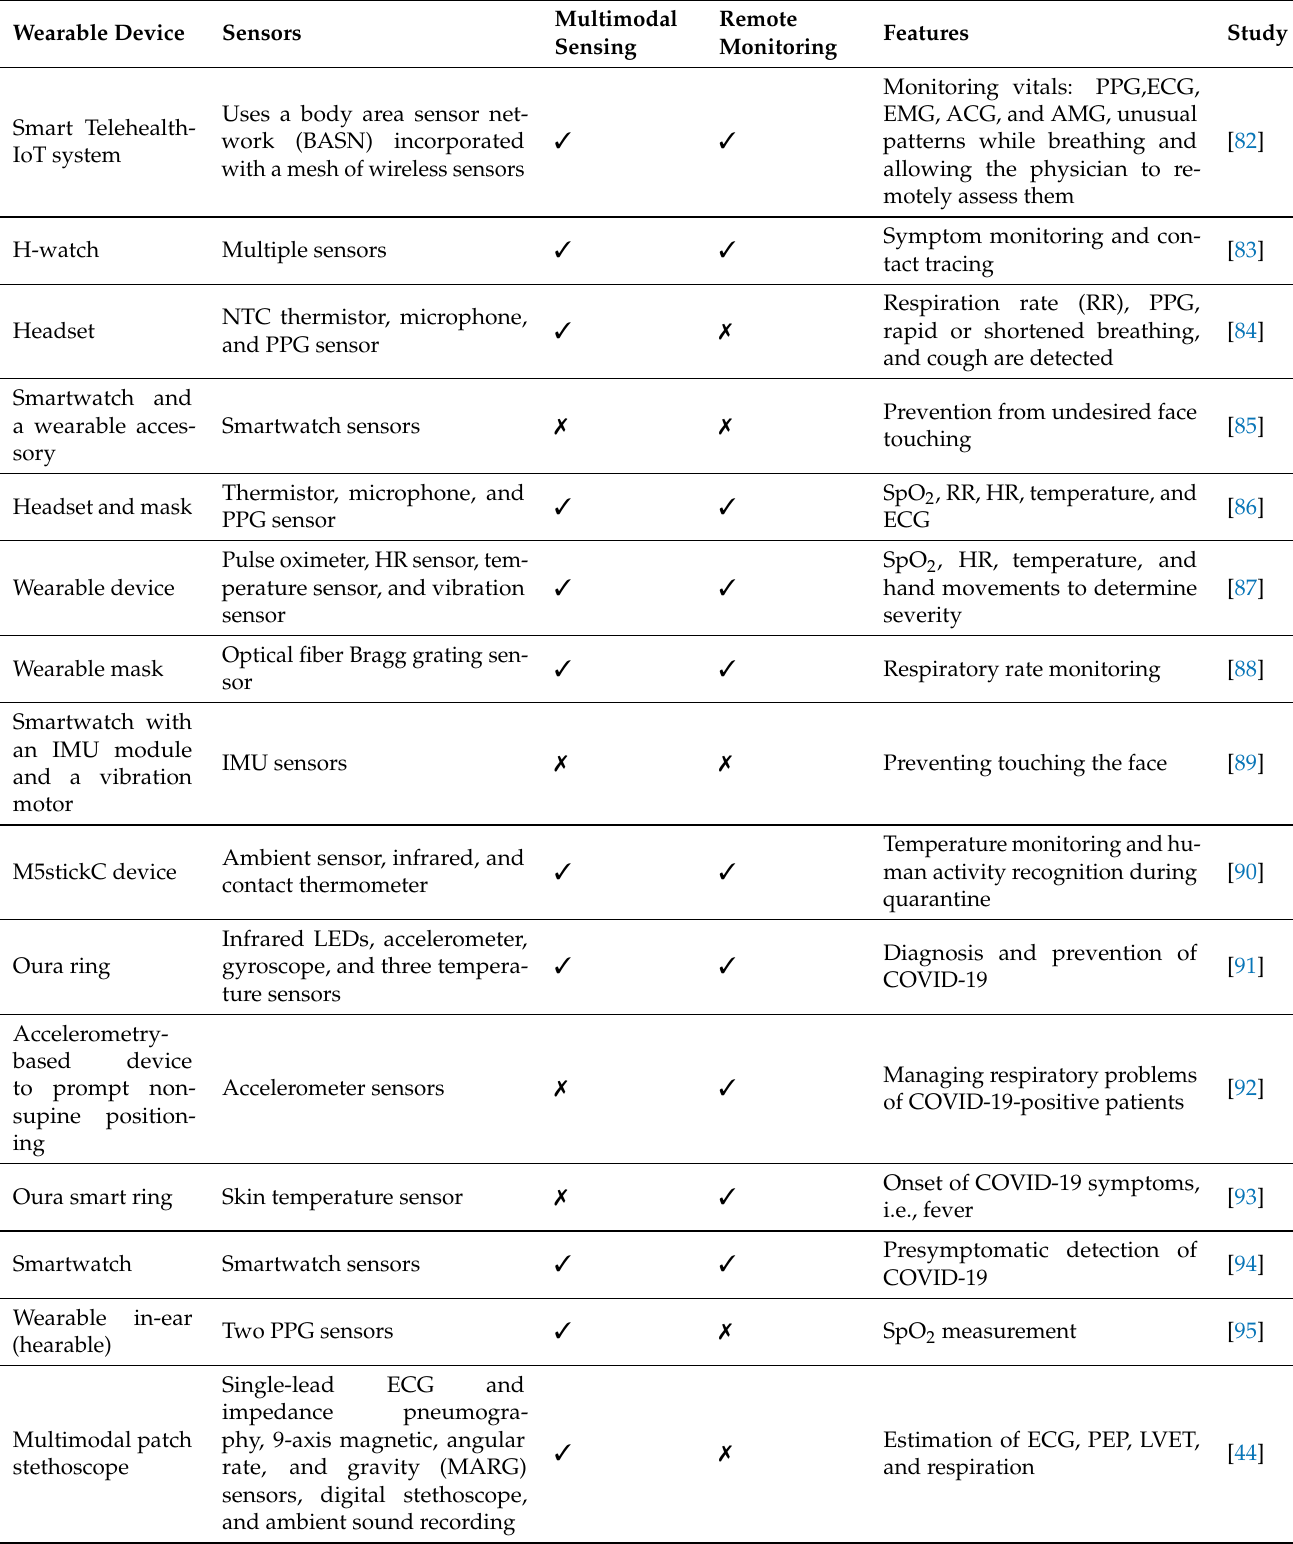
Table 3. Summary of recent research studies performed on the screening, tracking, and prevention of COVID-19. Wearable